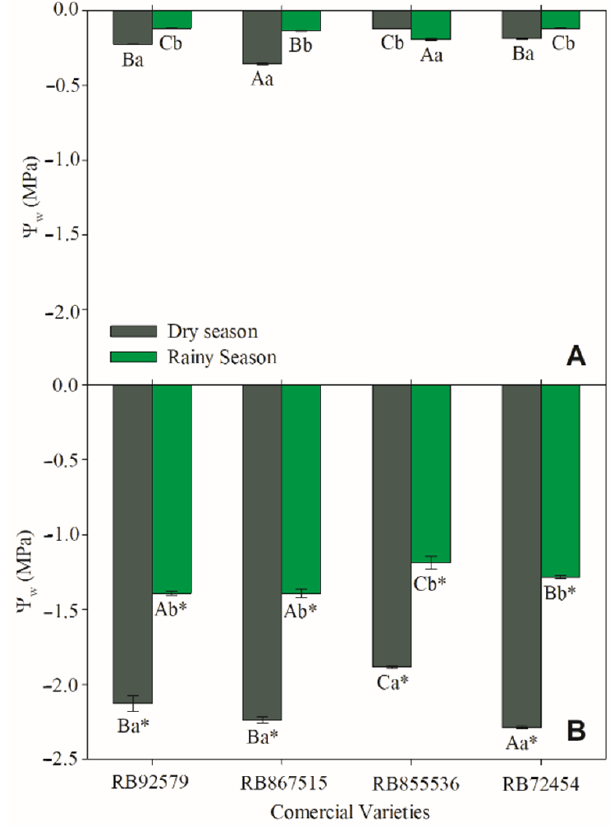
Figure 6. Predawn ( A ) and midday ( B ) water potential measured in four varieties (RB92579, RB867515, RB855536, and RB72454) of sugarcane. The evaluations were made in dry season (gray bars) and rainy season (green bars). Different lowercase letters denote significance within season for each variety, and different capital letters denote significance within varieties for the same season. An asterisk (*) denotes significance within predawn and midday measurements in the same